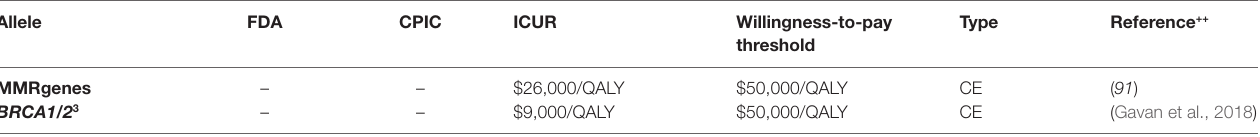
TABLE 3 | Genomic tests covered by